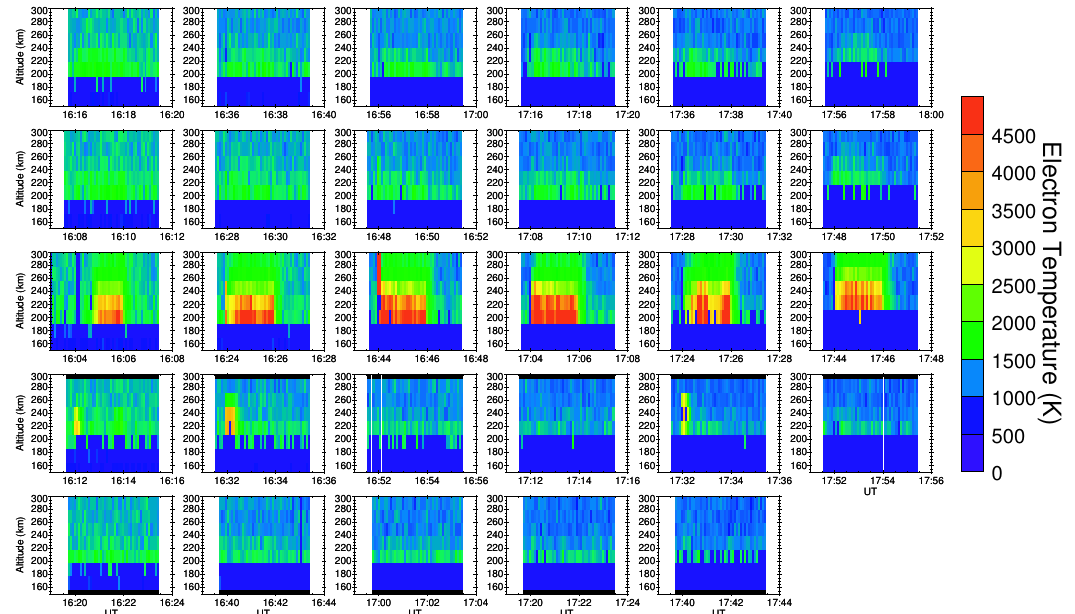
Fig. 5. Electron temperatures for 16:00–18:00 UT on 25 September 2002 for FA heater pointing. The five rows correspond to the five UHF pointing directions: FA+12, FA+6, FA, FA − 6 and FA − 12. Each panel shows the altitude plotted against the time, with the colours corresponding to the electron temperature. Temperature increases corresponding to heater-on are present in most directions. The highest increases are in FA, with temperatures up to 5000K. The increased temperature persists for the entire period that the heater remains on.